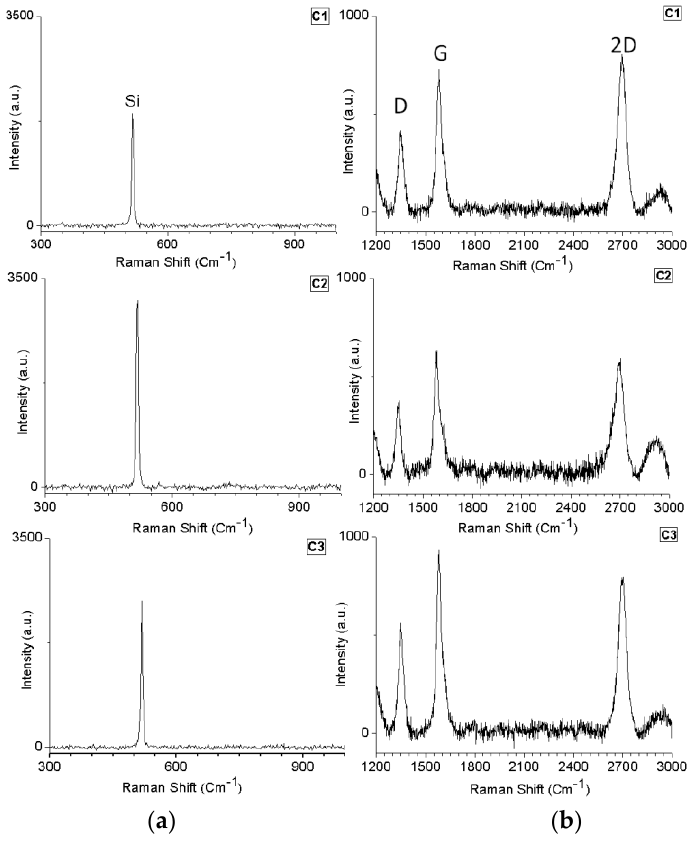
Figure 2. Raman spectra of the samples C1, C2 and C3: ( a ) scanning in the SiC area (column A); ( b ) scanning in the graphene area (column B).